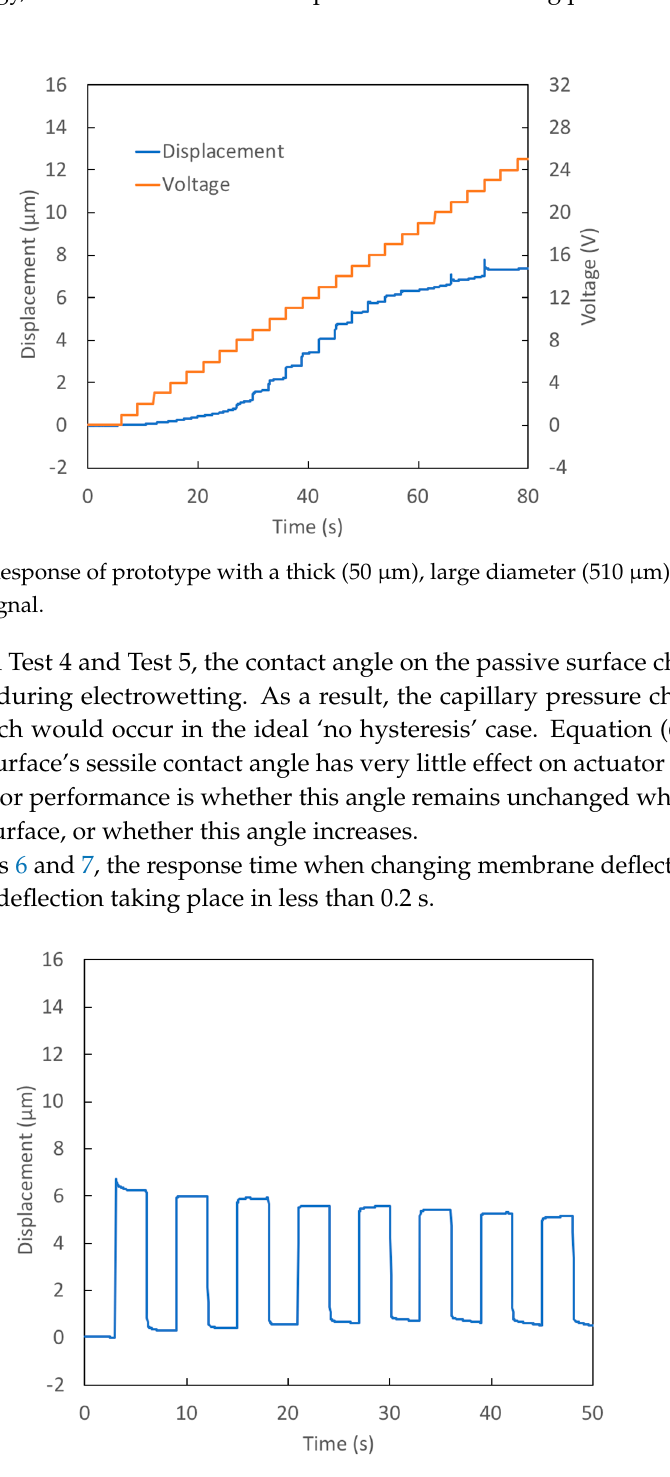
Figure 6. Test 4—Response of prototype with a thin (39 µ m), small diameter (438 µ m) membrane to 14 V square wave voltage signal.